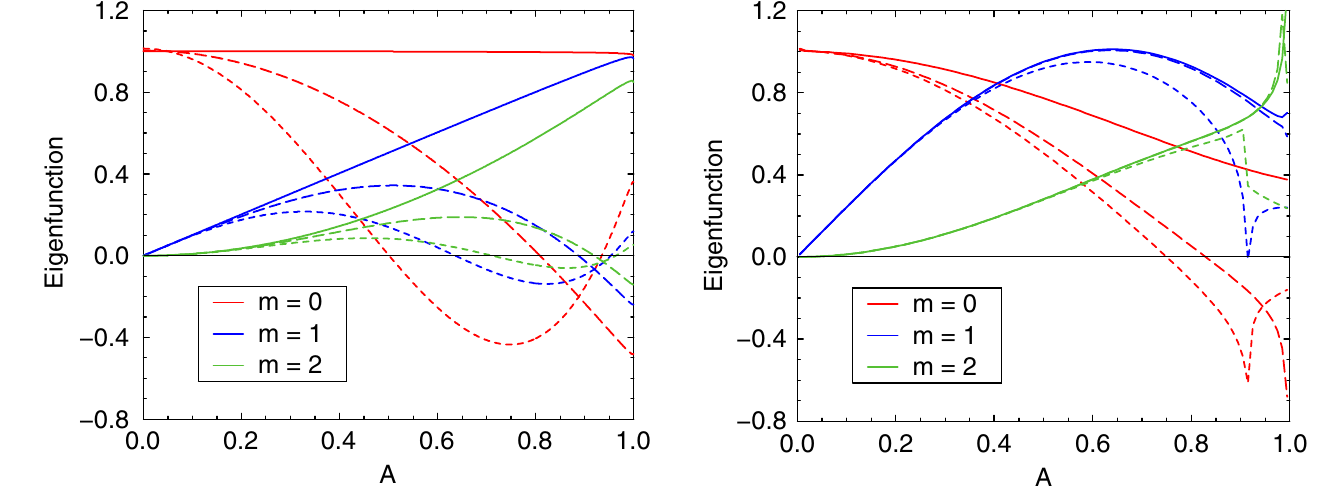
FIG. 12. (Color) Modified eigenvalues of the ‘‘superparabolic’’ bunch.